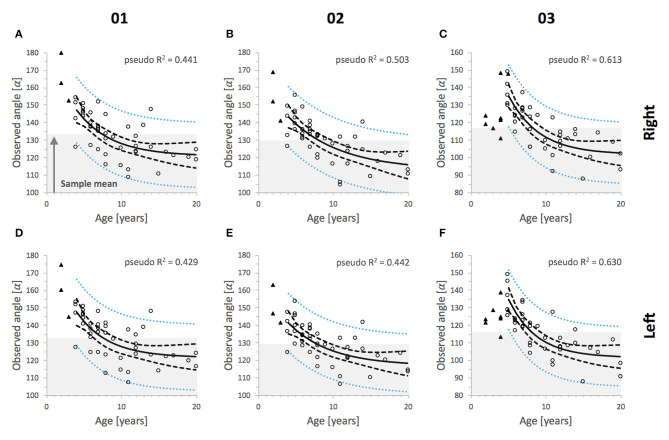
Non-linear regression analysis shows the association of observed IIA values and the age of horses by tooth position and side. (A–C) right side, (D–F) left side; α, alpha angle degrees. The upper limit of gray areas indicates mean values for permanent incisors. IIA data from deciduous incisors (triangles) were not included in the analysis. Pseudo-R2 was calculated for each tooth position and displayed in the plots, n = 45 horses (01 and 02), n = 40 horses (03). Lines indicate trend lines; inner dashed lines indicate upper and lower 95% confidence intervals for the non-linear regression line and outer dotted lines indicate upper and lower 95% prediction intervals.